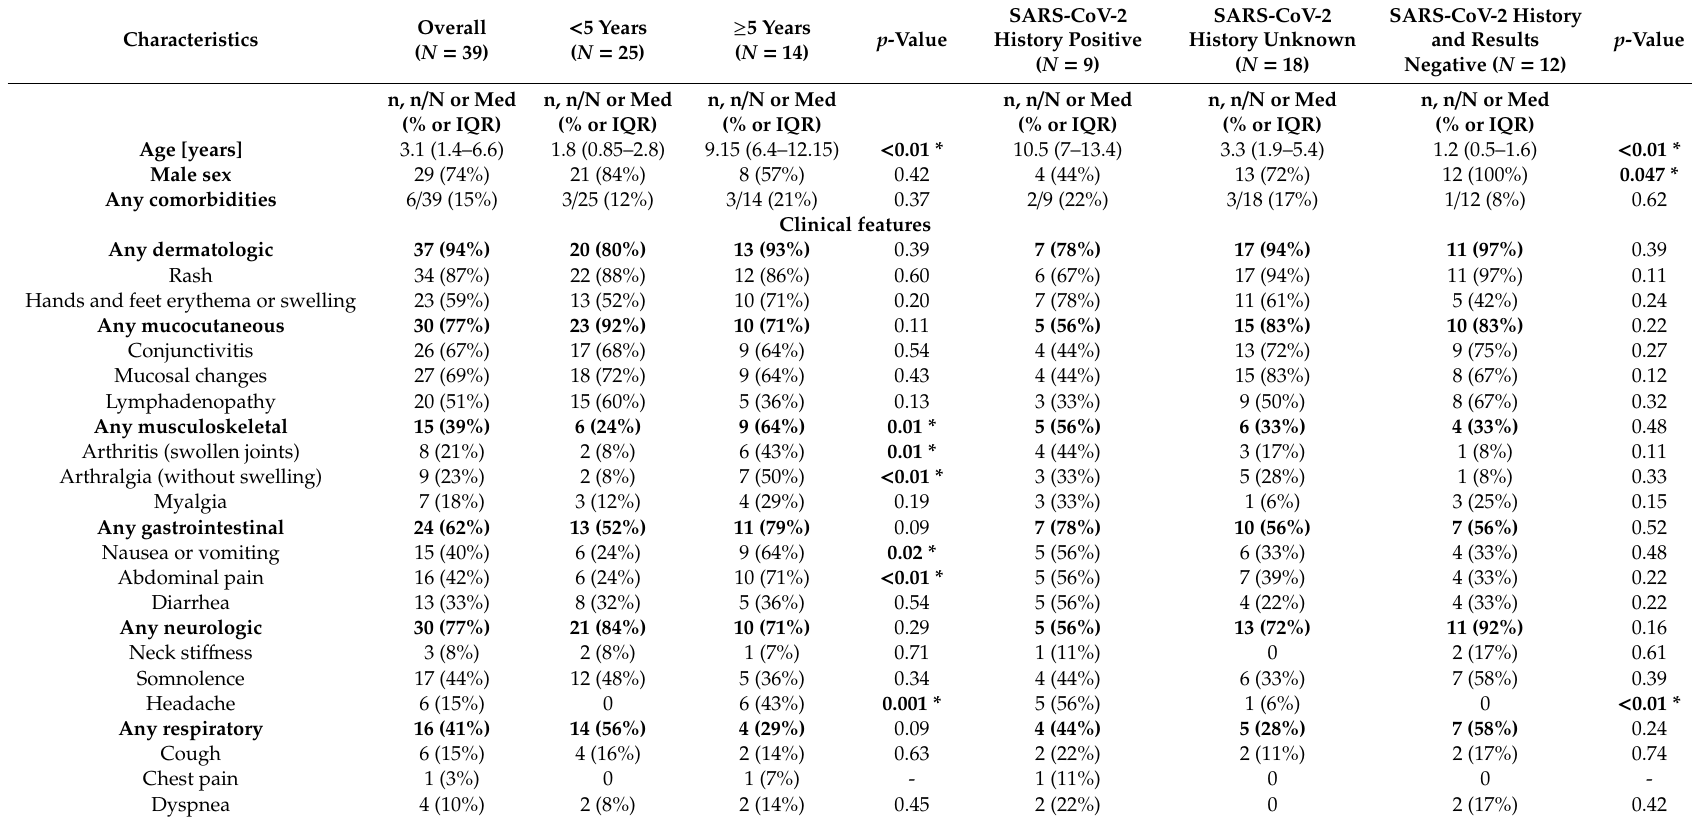
Table 2. Demographic and clinical characteristics of the patients, according to age group and SARS-CoV-2